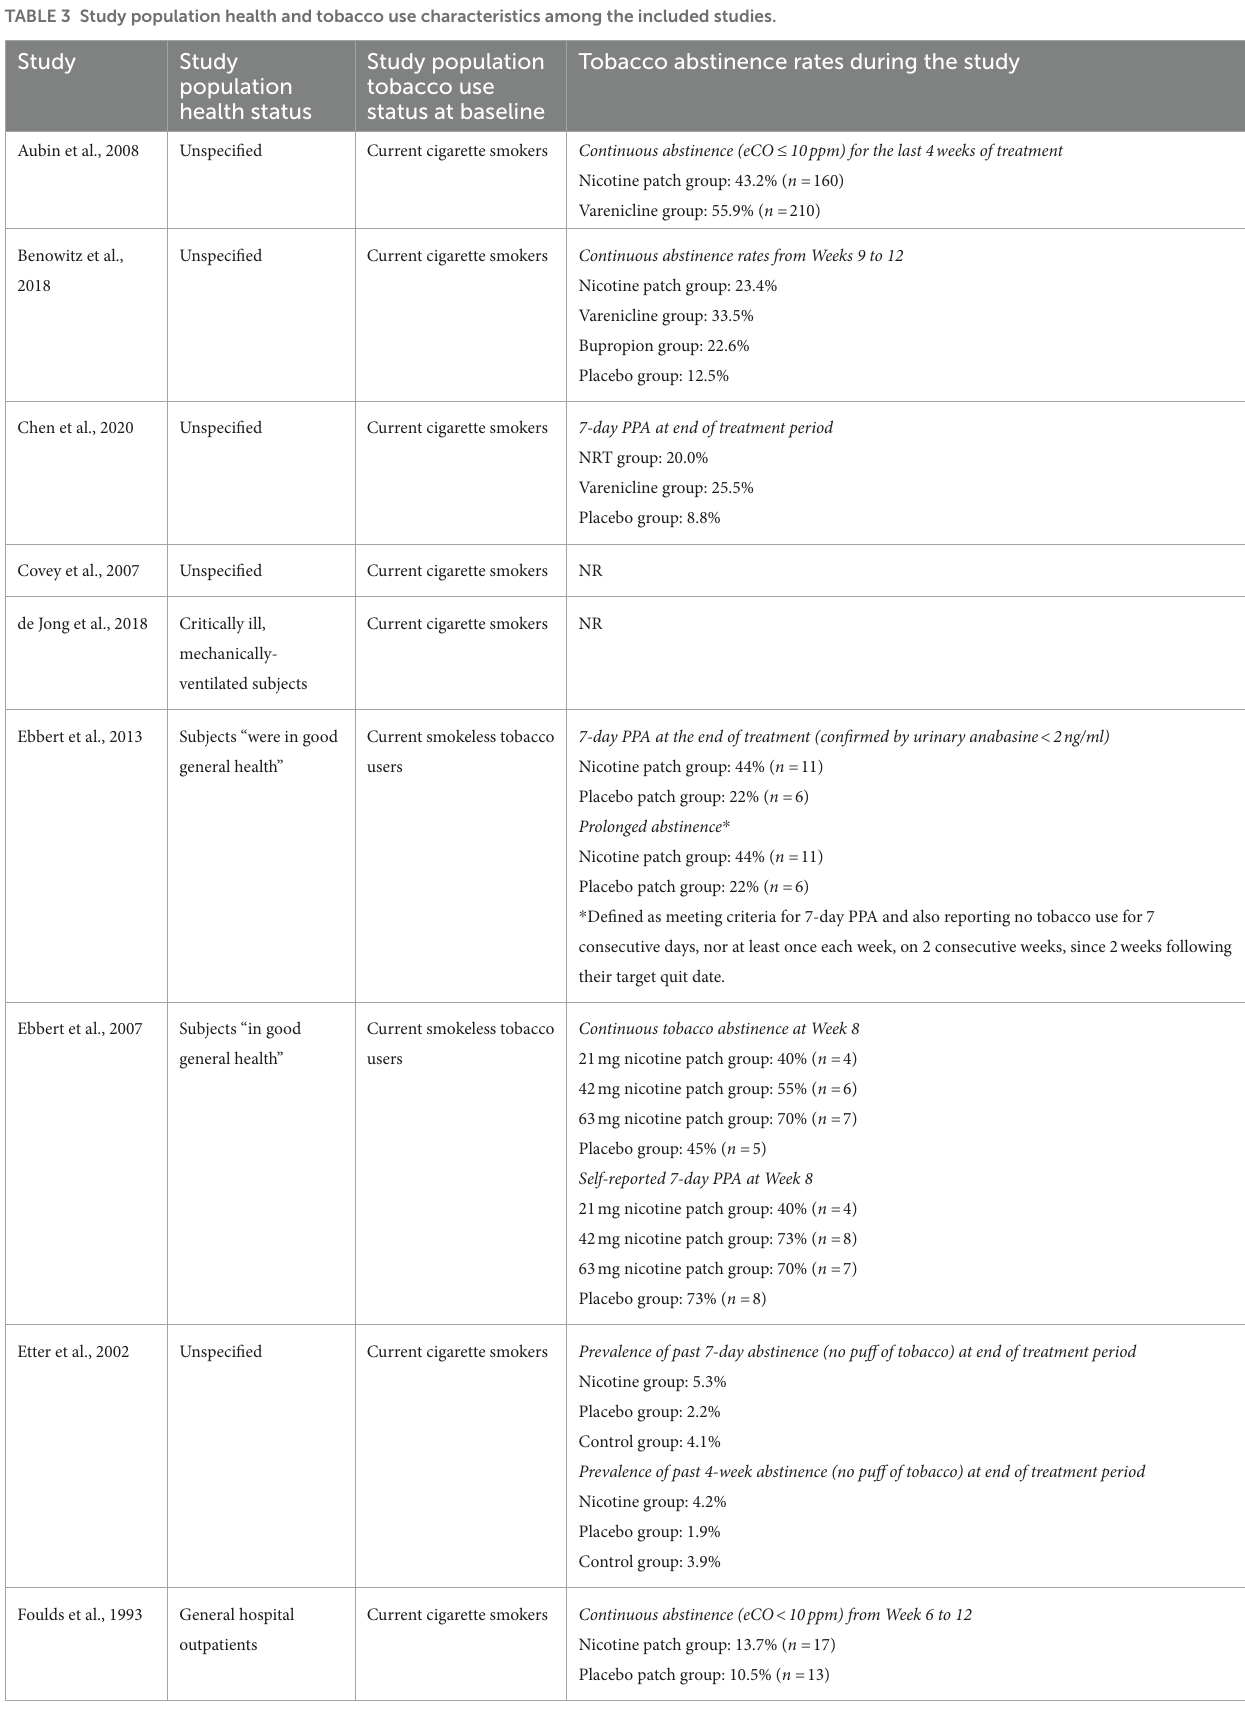
TABLE 3 Study population health and tobacco use characteristics among the included